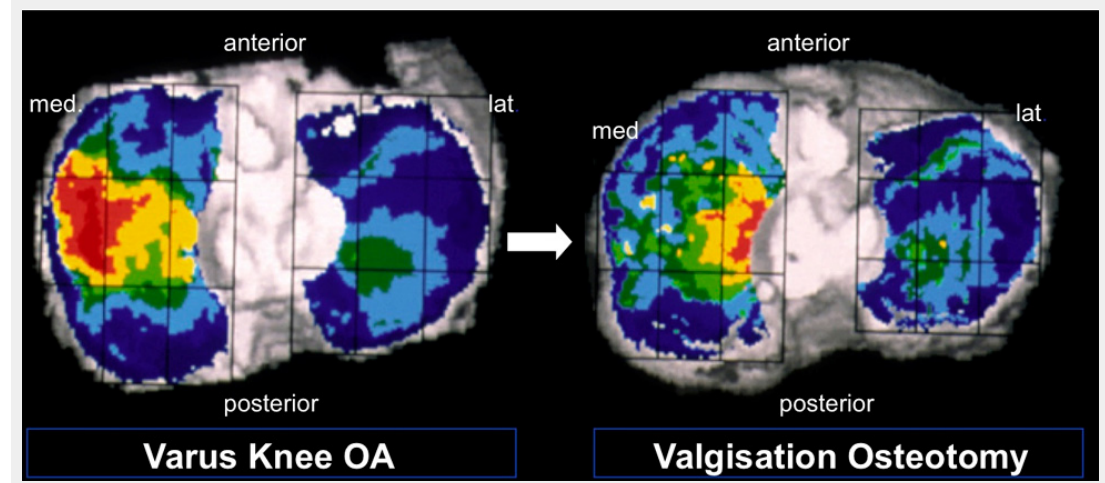
Figure 6 CT-OAM before and 2 years after valgisation osteotomy of the proximal tibia. Areas with high subchondral bone density are coloured in red and yellow (© Madry H, van Dijk CN, Mueller-Gerbl M. The basic science of the subchondral bone. Knee Surg Sports Traumatol Arthrosc. 2010;18(4):419–33. Reprinted with kind